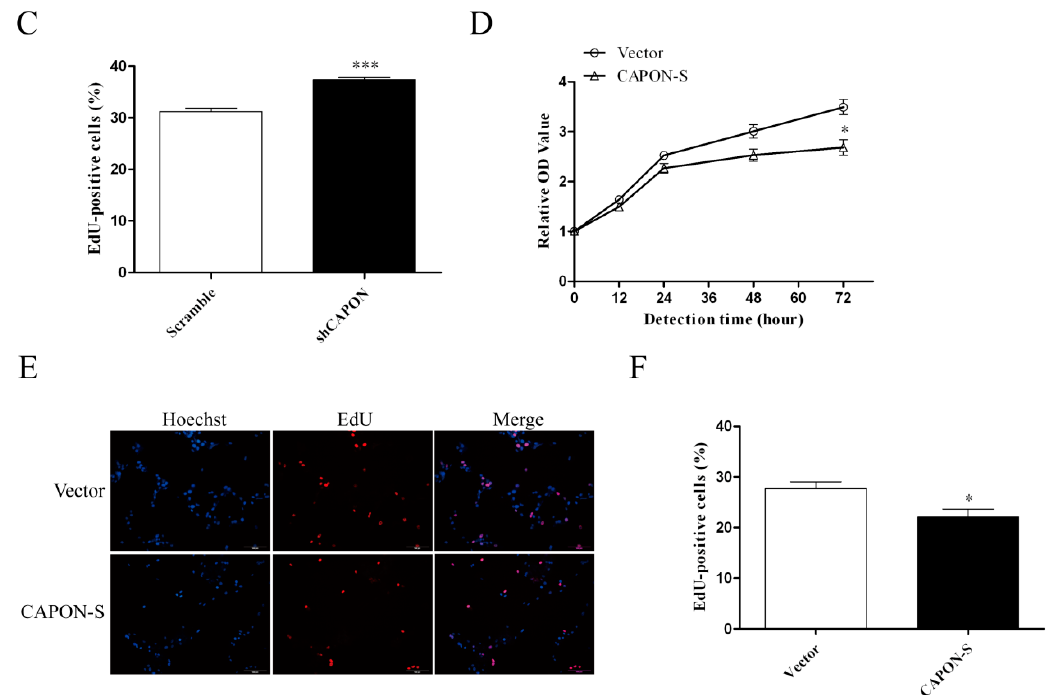
Figure 3. Influences of CAPON-S on the proliferation of glioma cells. ( A ) CCK8 assay was used to measure the cell viability in Scramble and shCAPON C6 glioma cells; ( B , C ) EdU assay was used to evaluate the proliferation of Scramble and shCAPON C6 glioma cells. Representative images for EdU-positive C6 glioma cells (red) and Hoechst-stained nuclei (blue) are shown in B (Magnification × 100). Quantification of the percentage of EdU-positive cells is shown in C ; ( D ) CCK8 assay was used to assess the cell viability in Vector and CAPON-S U87 glioma cells; ( E , F ) EdU assay was used to evaluate the proliferation of Vector and CAPON-S U87 glioma cells. Representative images for EdU-positive U87 glioma cells (red) and Hoechst-stained nuclei (blue) are show in E (Magnification × 100). Quantification of the percentages of EdU-positive cells is shown in F. (* p < 0.05; ** p < 0.01; *** p < 0.001).